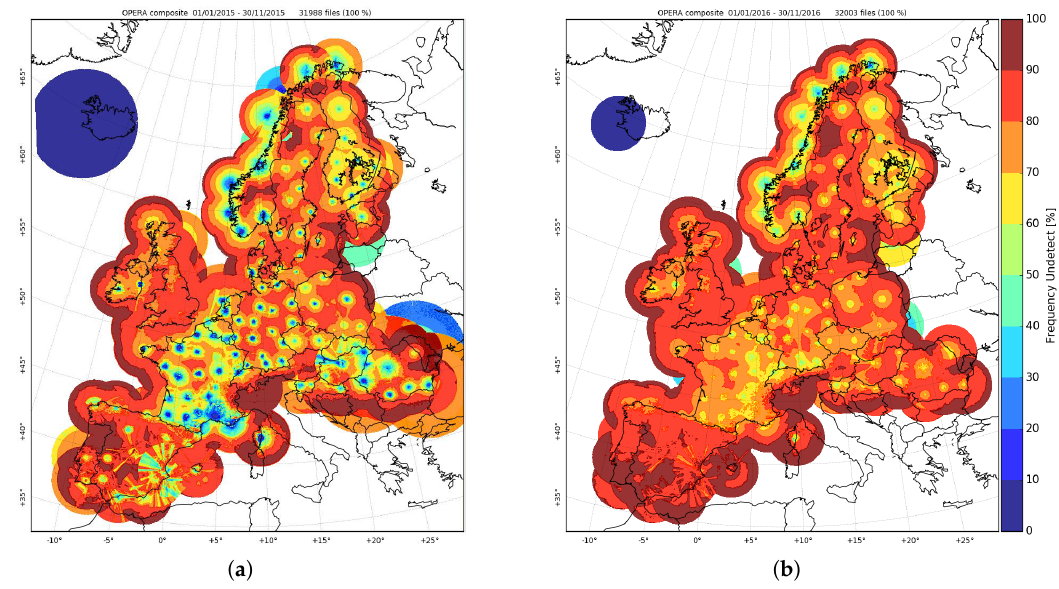
Figure 4. Frequency of undetect values in ( a ) January–November 2015 and ( b ) January–November